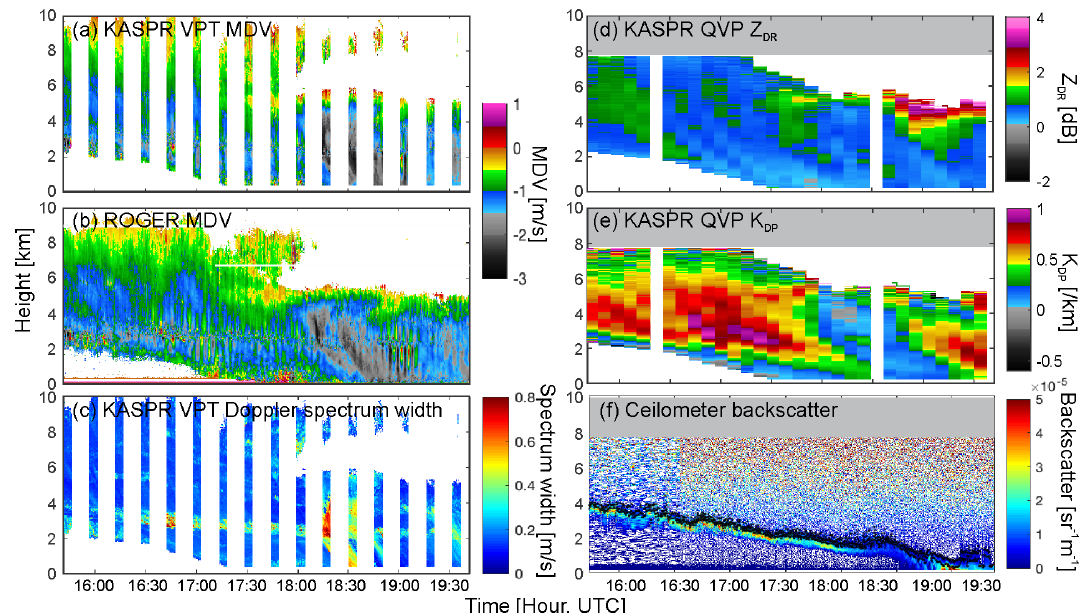
Figure 5. Height–time cross sections of (a) MDV from the KASPR VPT measurements, (b) MDV from the ROGER measurements, (c) spectrum width from the KASPR VPT measurements, (d) QVP of KASPR Z DR , (e) QVP of KASPR K DP , and (f) ceilometer backscatter on 20 February 2019. Black dots in (f) represent cloud base